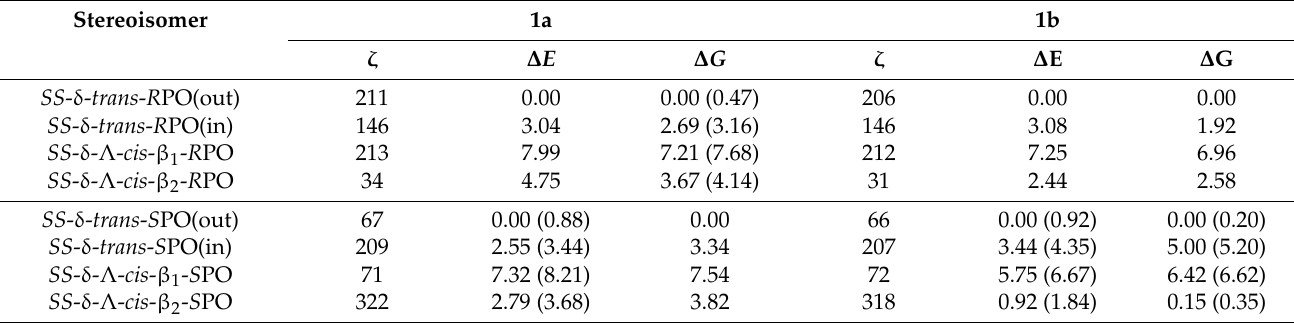
Table 1. Relative electronic-energy and free-energy values ( ∆ E and ∆ G , in kcal/mol) of the lowest-energy R PO and S PO epoxide complexes within each group of considered stereoisomers of 1a and 1b . Dihedral angle ζ (in o ) describes orientation of epoxide relative to the Co(III)-salcy fragment, (see Figure 7). The relative electronic energies/free energies of R PO/ S PO complexes were calculated with respect to the lowest-energy R PO/ S PO structure, while the numbers in parentheses correspond to the relative electronic-energy/free-energy values calculated with respect to the “global minimum” epoxide